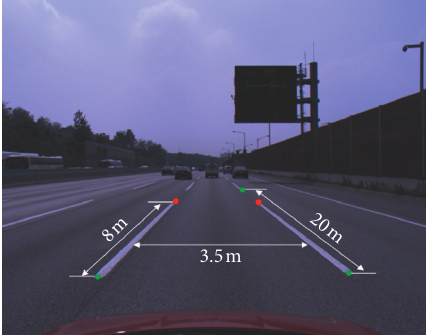
Figure 1: Lane endpoints and the printed regulation of dashed lane markings on a